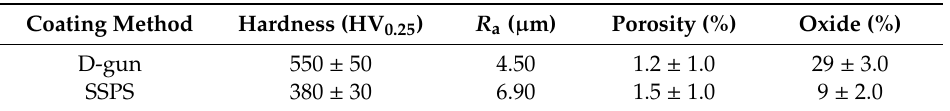
Table 3. Hardness, surface roughness, porosity and oxide content of CoNiCrAlY coatings produced with the D-Gun and SSPS techniques.